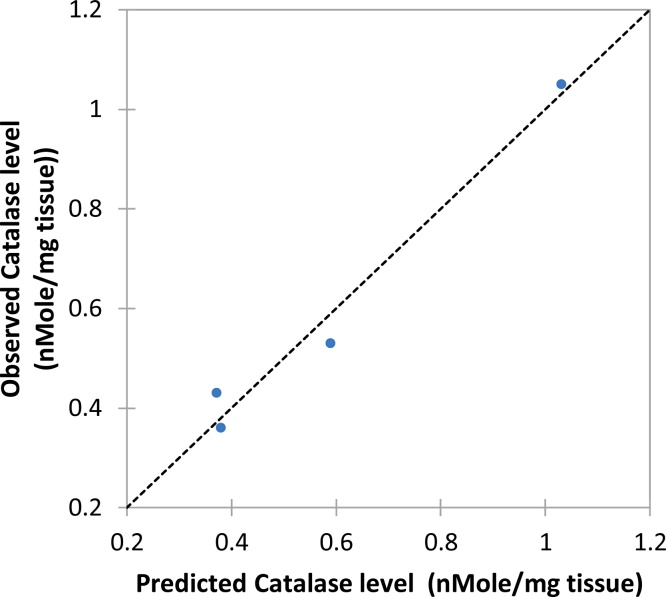
Predicted brain catalase level (nMole/mg tissue) against observed brain catalase level; where y = Catalase levels; x = Costus afer concentrations served as input values.